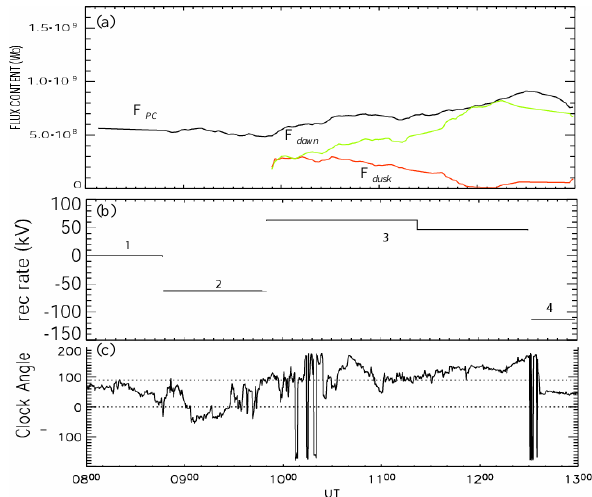
Fig. 4. (a) Total polar cap flux (black curve), and flux contained dawnward (green curve) and duskward (red curve) of the transpolar arc, determined from the auroral observations. (b) Reconnection rates derived from the changes in polar cap flux (see text for more details). (c) IMF Bz